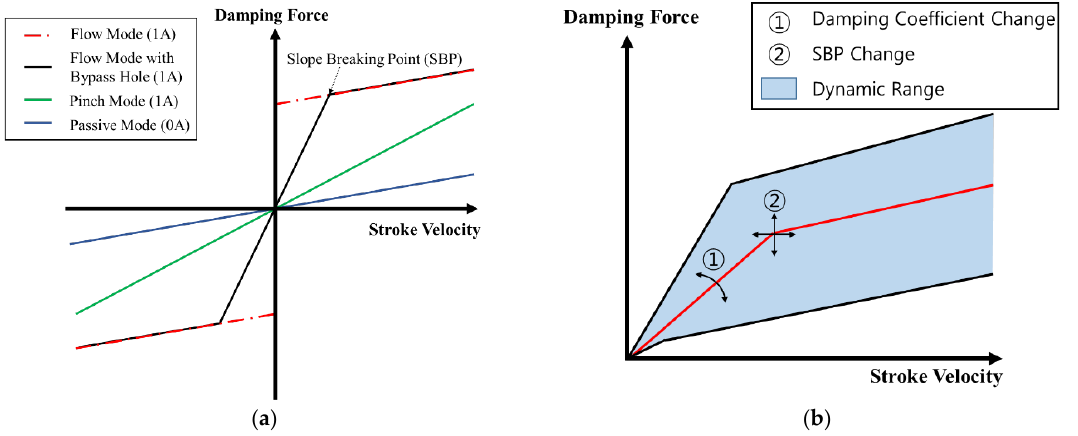
Figure 2. Damping force characteristics of magnetorheological (MR) damper: ( a ) conventional operation mode and ( b ) proposed mode with pole shape function.